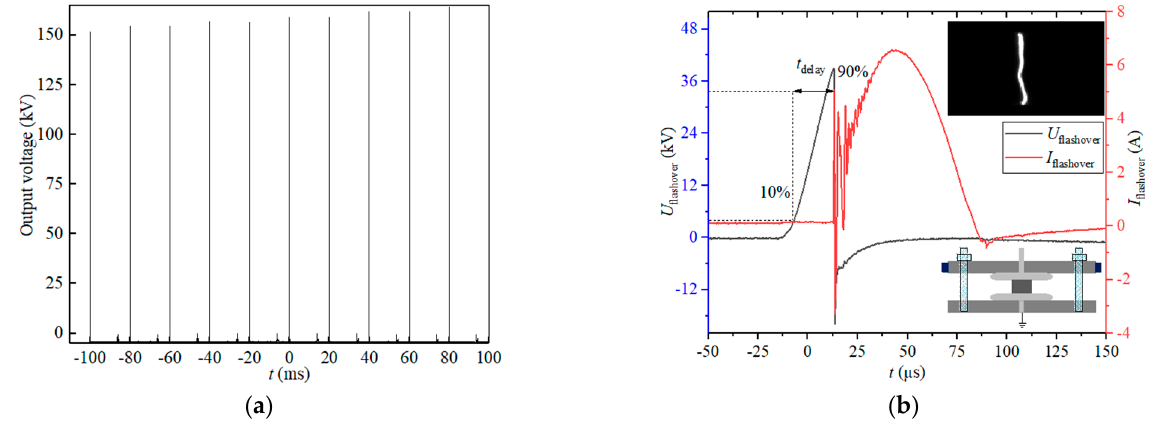
Figure 3. ( a ) Output of the generator and ( b ) flashover waveforms of voltage and current.